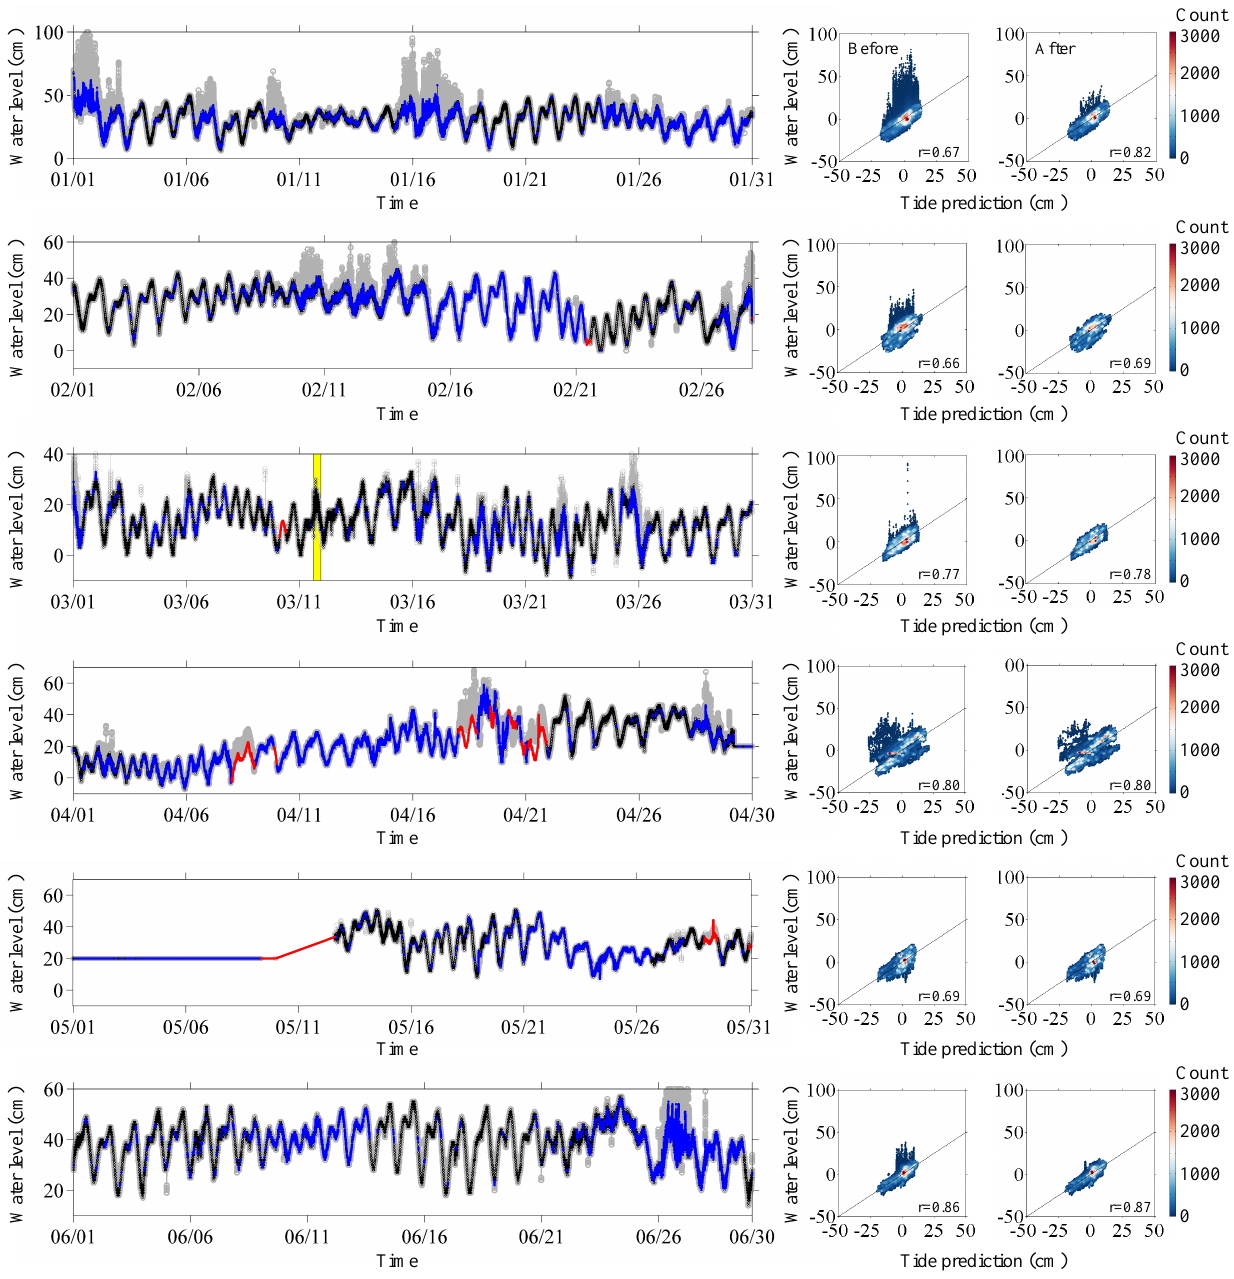
Figure 12: Performance test of the outlier removal and gap filling algorithms. (Left) Time-series of the Ulleung-do surge gauge after applying Figure both outlier removal and gap filling algorithms (black line). Outliers are marked by a gray line and gap-filled data are marked by a blue line (SGFA) and a red line (LGFA). The yellow box in March indicates the event period. (Middle and right) Scatter plots show the comparison between before and after applying both outlier removal and gap filling algorithms. The mean value of each axis in the scatter plot is fixed to 0 by subtracting the mean value of each data from its data. The color point represents the frequency of data plotted inside the circle with a radius of 1 cm. The right corner represents the correlation coefficients.